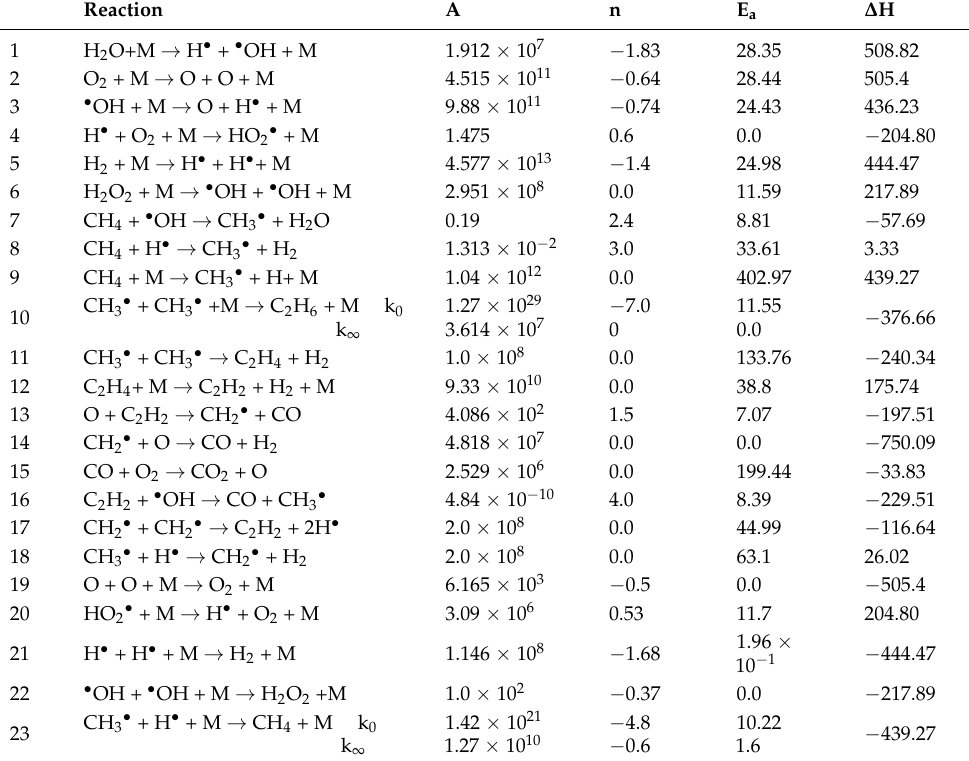
Table 3. Scheme of the possible chemical reactions inside a collapsing Ar–CH 4 -bubble [32,33]. M is the third Body. A is in (m 3 mol − 1 s − 1 ) for two-body reaction [(m 6 mol − 2 s − 1 ) for a three-body reaction], and E a is in (KJ mol − 1 ) and ∆ H in (KJ mol − 1